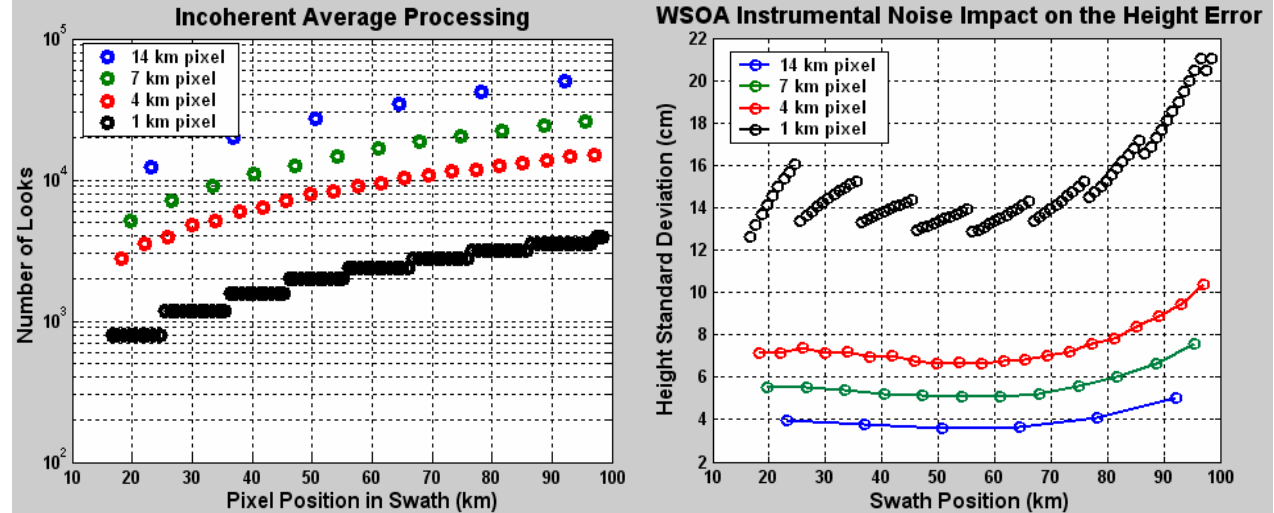
Figure 6. (a) Number of looks associated with different incoherent average processing procedures in the range direction (b) Associated WSOA instrumental noise impact on the height error (the digitization step in the number of looks is related to the intrinsic range resolution, that results in discontinuity when considering 1 km